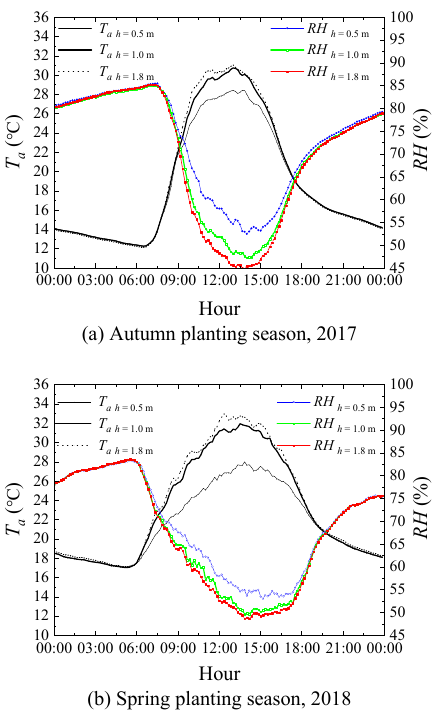
Figure 3. Time evolution of average air temperature ( T a ) and relative humidity ( RH ) at three observation heights (0.5, 1.0, and 1.8 m above the ground) ( a ) from 2 to 10 November 2017 (autumn planting season) and ( b ) from 2 to 10 May 2018 (spring planting season).